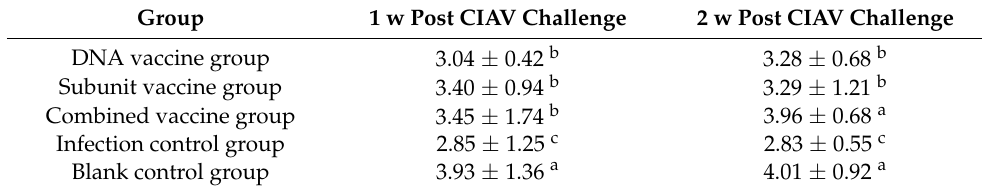
Table 5. Thymus index after CIAV challenge.